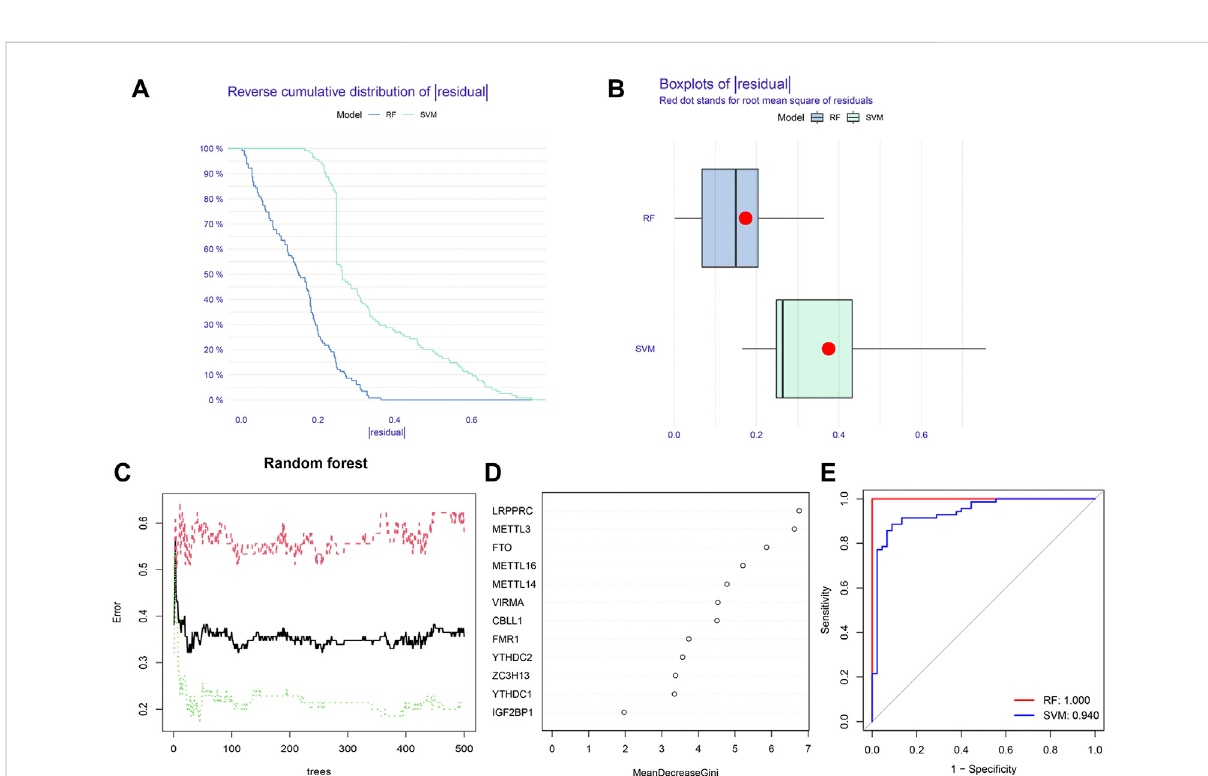
FIGURE 4 Construction of random forest (RF) model and support vector machine (SVM) model. (A) Reverse cumulative distribution of residual of RF and SVM model. (B) Boxplots of residual of RF and SVM model. (C) Cross-validation curve of RF model. (D) The importance of the 12 signi fi cant m6A regulators. (E) ROC curves of RF and SVM